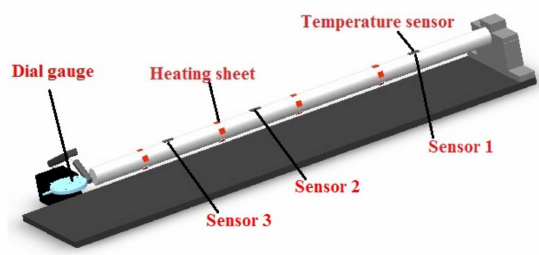
Figure 17. Location of the temperature sensors, heating sheets, and dial gauge.